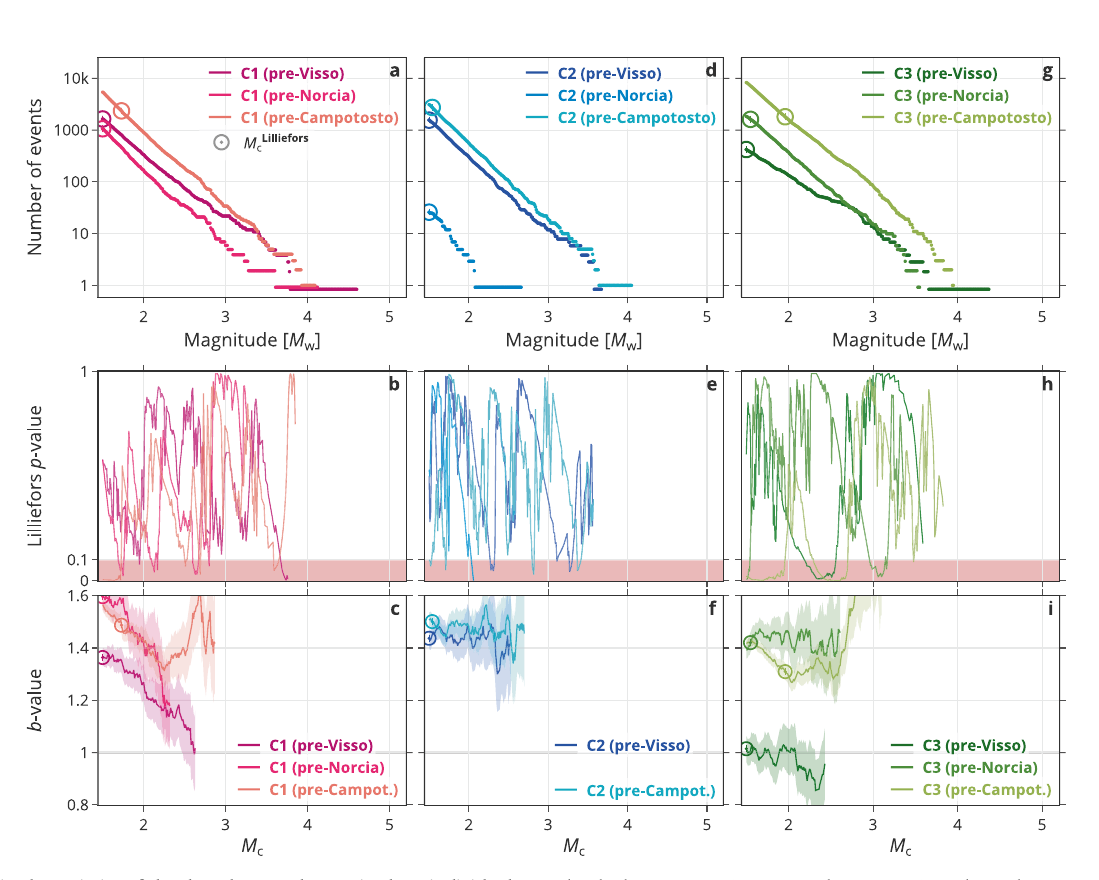
the shading representing 1 σ . Supplementary Fig. 4 shows the same analysis using local magnitudes. Supplementary Figs. 7 and 8 compare the periods shown here with periods that include STAI.